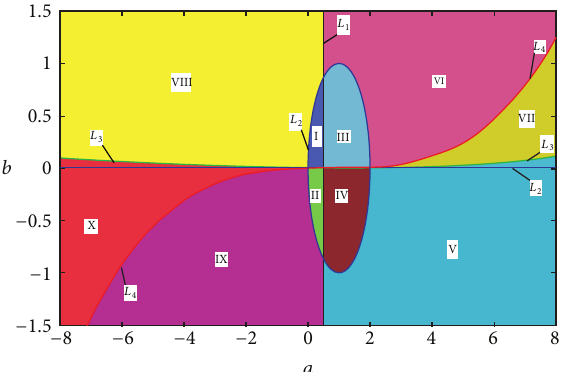
Figure 6: The stable region on the parameter plane (𝑎,𝑏) .